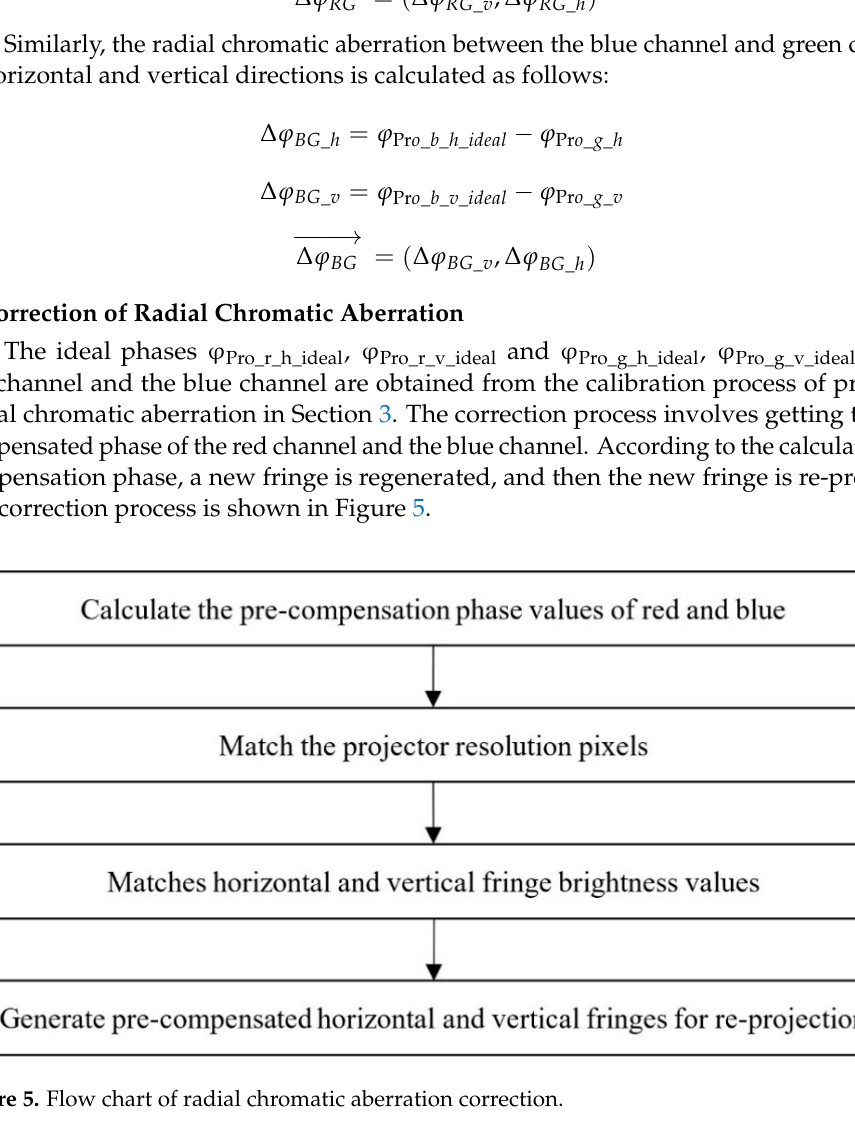
Figure 6. Phase mapping relationship of chromatic aberration compensation for the red channel. 2.